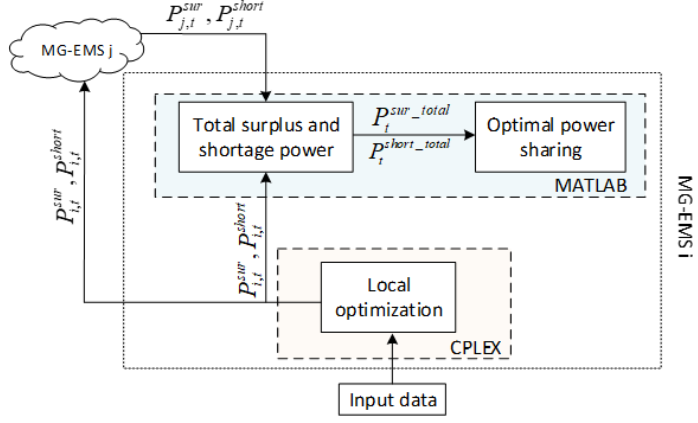
Figure 5. Simulation setup schematic for microgrid operation.